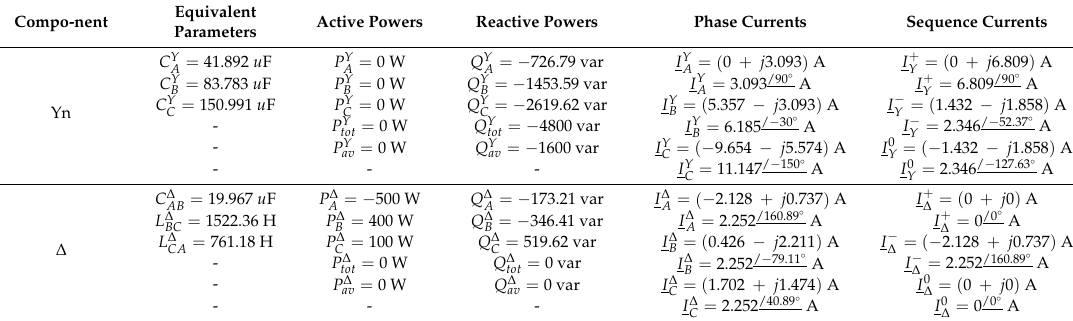
Table 2. The unbalanced compensator—initial sizing (BRC).